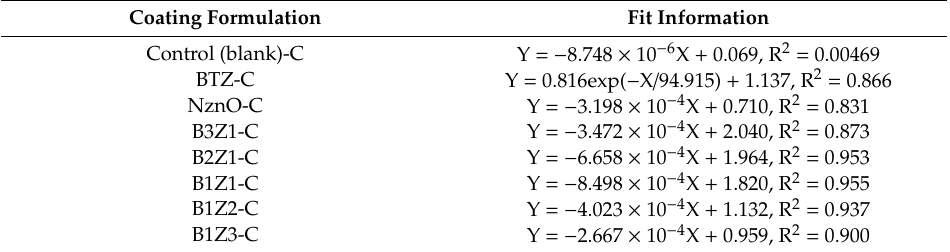
Figure 8. Changes in the average UV absorbance of BTZ–NZnO films containing different BTZ–NZnO ratios. Table 4. Fit information of the mean absorbance of free films with increasing aging